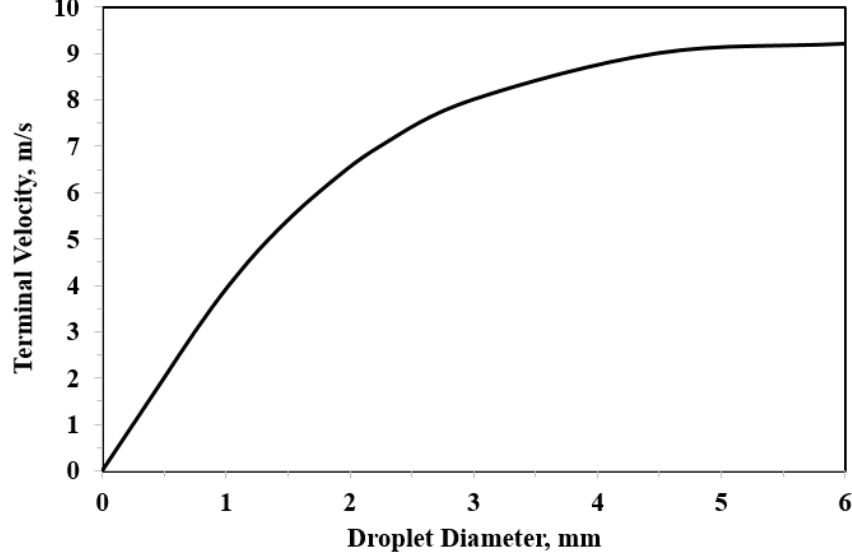
Figure 6. Dependence of terminal velocity of free-falling droplets on droplet size [6].